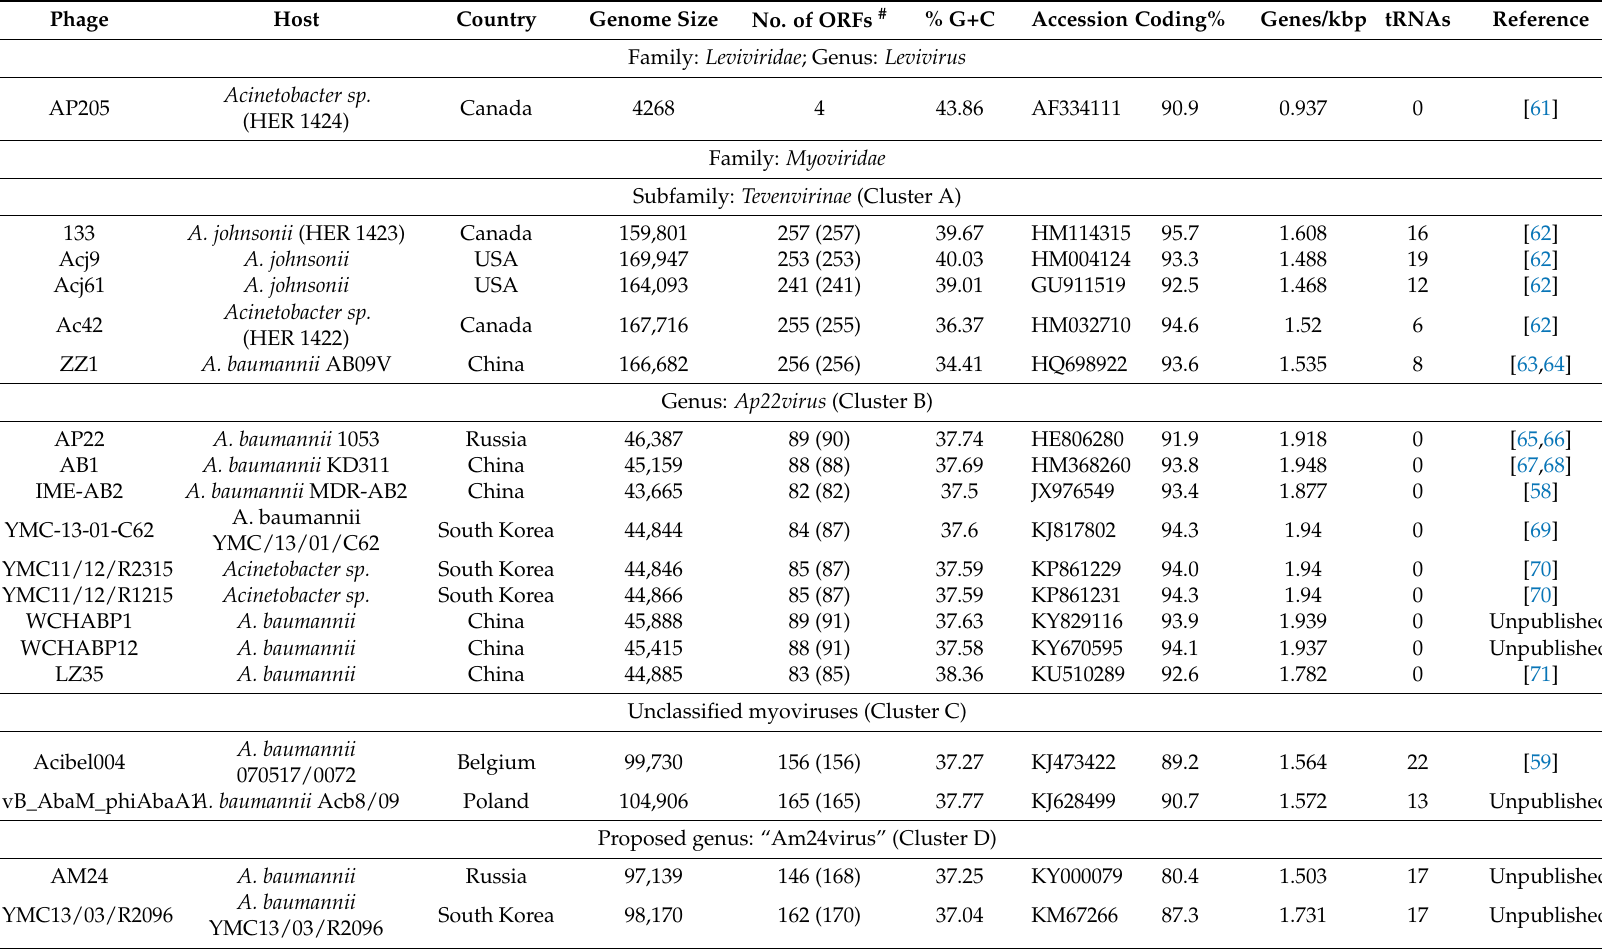
Table 1. Characteristics of Acinetobacter bacteriophage genome sequences deposited in the International Nucleotide Sequence Database. Phages are grouped according to International Committee on Taxonomy of Viruses (ICTV) taxonomic assignments and on the basis of average nucleotide identity and shared gene